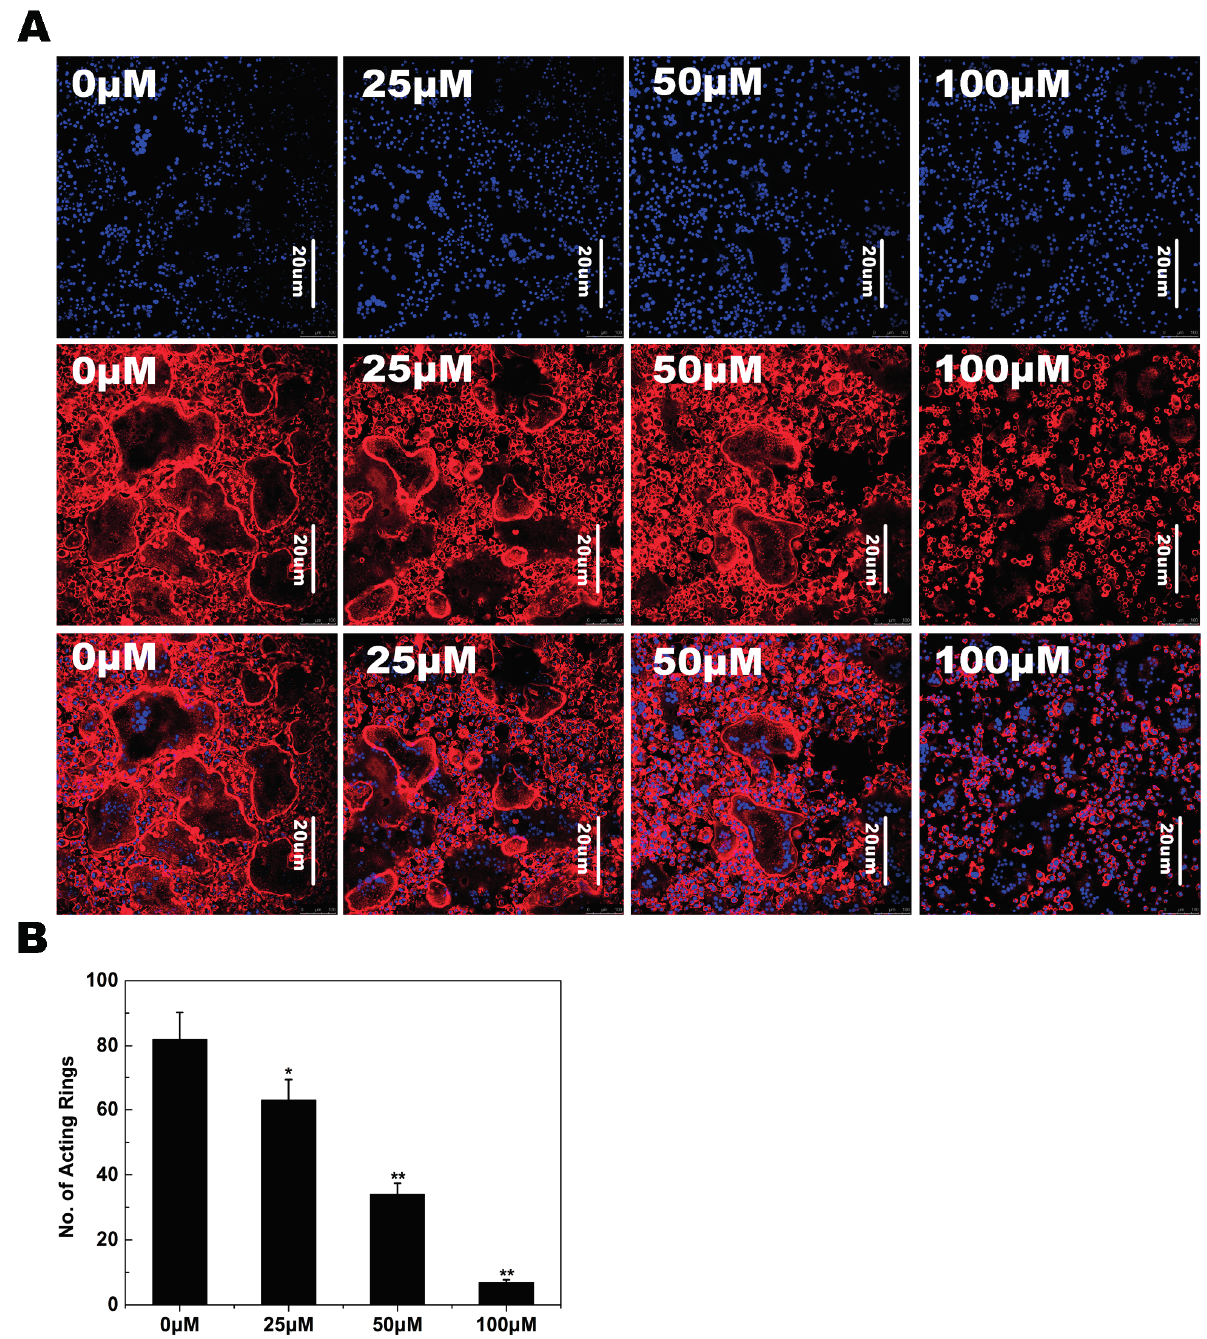
Figure 3. Naringenin (NAR) inhibited receptor activator of the nuclear factor- κ B ligand (RANKL)-induced F-actin ring formation. ( A ) Bone marrow macrophages (BMMs) were incubated with macrophage colony-stimulating factor (M-CSF) (30 ng/mL) and RANKL (50 ng/mL), followed by treatment with vehicle or NAR. Cells were fixed and stained for F-actin; ( B ) The number of osteoclasts with F-actin rings. * p < 0.05; ** p <